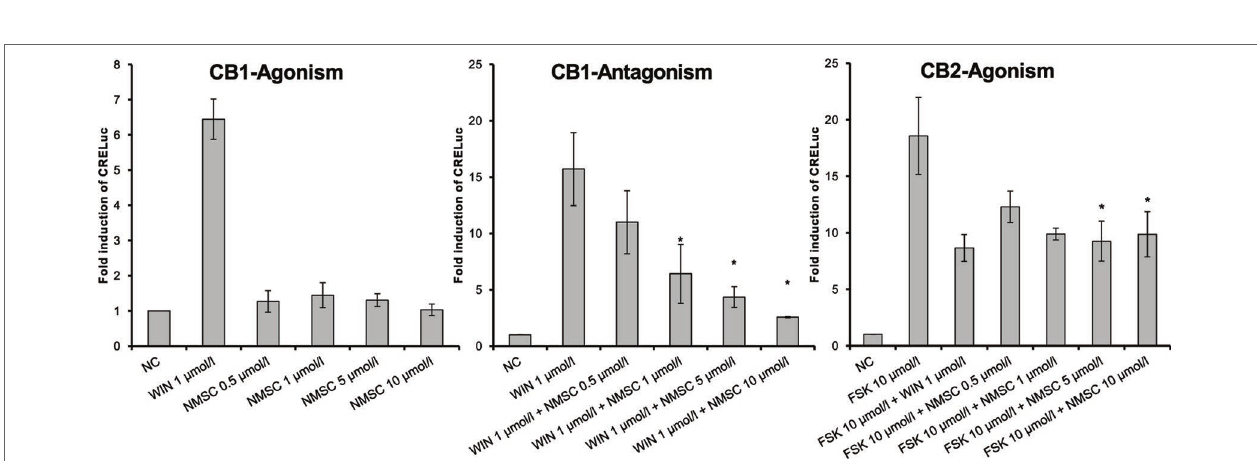
FigURE 4 | CB1‑ and CB2‑receptor‑mediated effects of NMSC ( 6 ) given as fold induction of CRE‑luc; CB, cannabinoid; FSK, forskolin; NC, negative control; NMSC, 2‑(methylsulfonamido)ethyl cannabidiolate, WIN, WIN 55212‑2; error bars represent SEM, * p < 0.1.